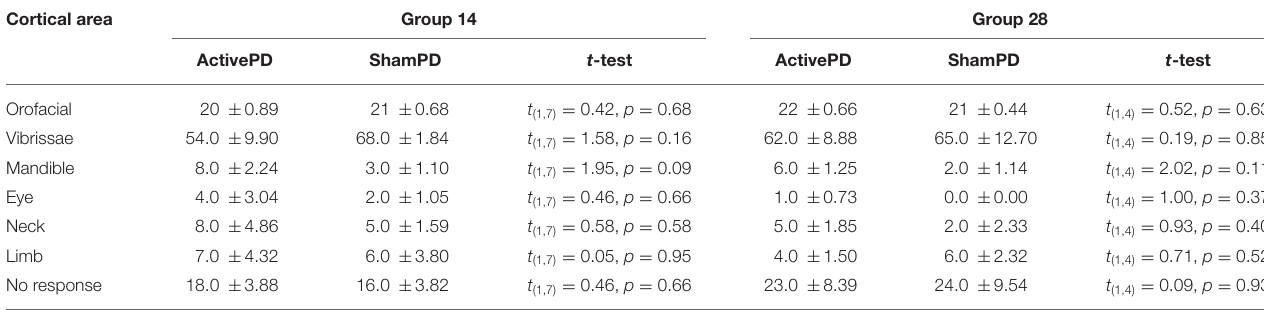
TABLE 3 | Percentage of representation of areas along the motor cortex. Cortical area Group 14 Group 28 ActivePD ShamPD t -test ActivePD ShamPD t -test